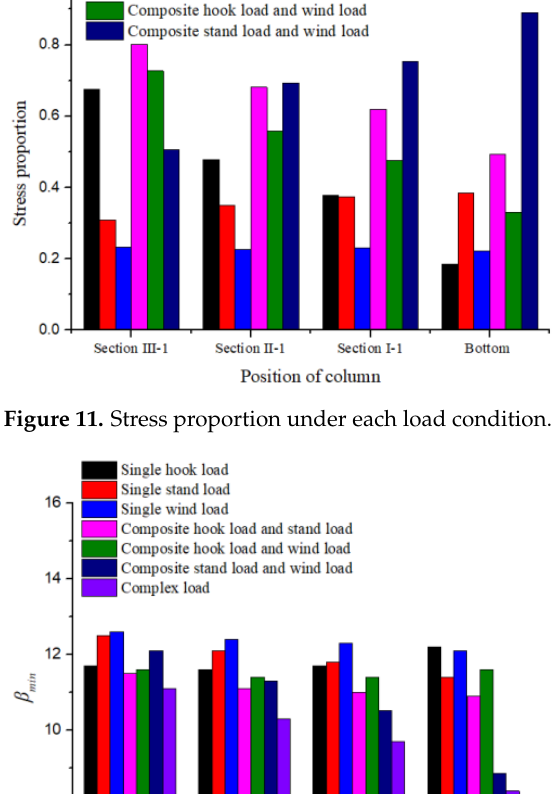
Figure 13. Influence of each load change on minimum reliability index under complex load. 6. Conclusions In this paper, based on the new reliability analysis programming and post-processing methods, the stress – strength reliability of the JJ315/45-K derrick under complex load is analyzed, and the following conclusions are drawn: (1) With the increase in hook load, the positions of maximum reliability risk appear in section II-1. With the increase in stand load or back wind load, the positions of maxi- mum reliability risk appear in the bottom section. It is necessary to monitor the stress of these risk columns.